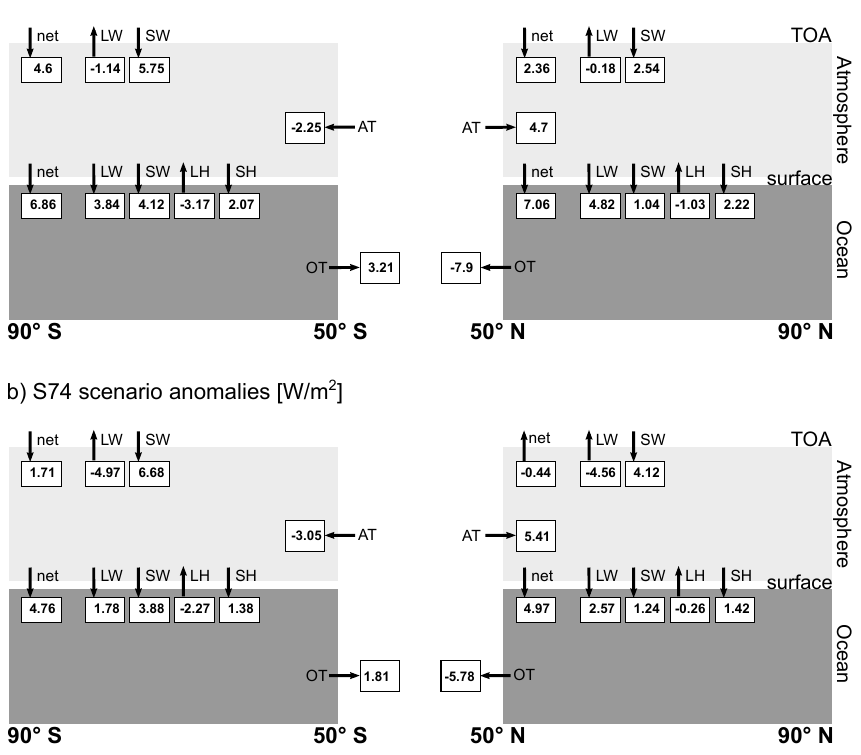
Fig. 7. Annual mean anomalies of the Earth’s energy budget components for (a) the C4x and (b) the S74 simulation. The energy budget anomalies are calculated for two boxes (90 ◦ S to 50 ◦ S and 50 ◦ N to 90 ◦ N) and the change in poleward atmospheric energy transport (AT) is also indicated. Values are in Wm − 2 and energy fluxes are defined as positive downward and northward.